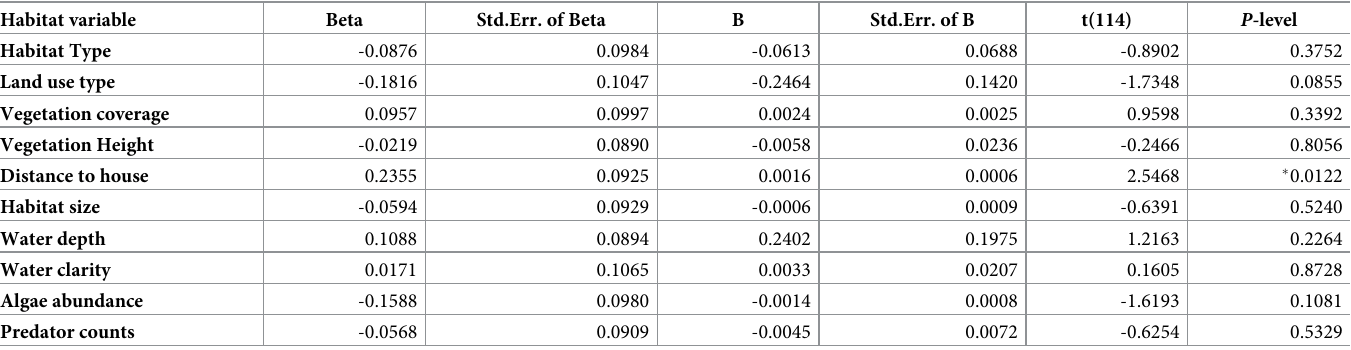
Table 3. Multiple regression analysis of factors associated with An . funestus larval